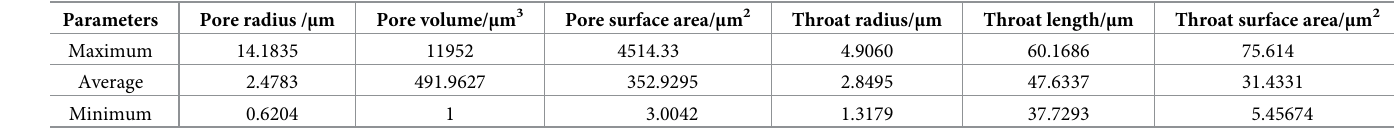
Table 3. Quantitative parameter statistics of pore network model in carbon fiber composites.